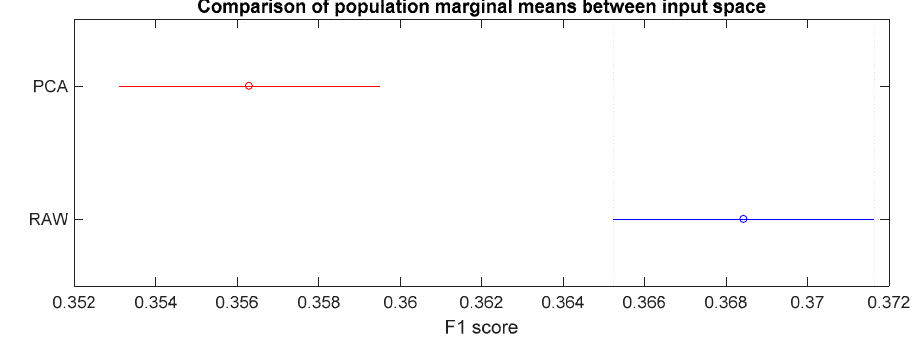
Figure 8. F1 scores for raw and projected data.